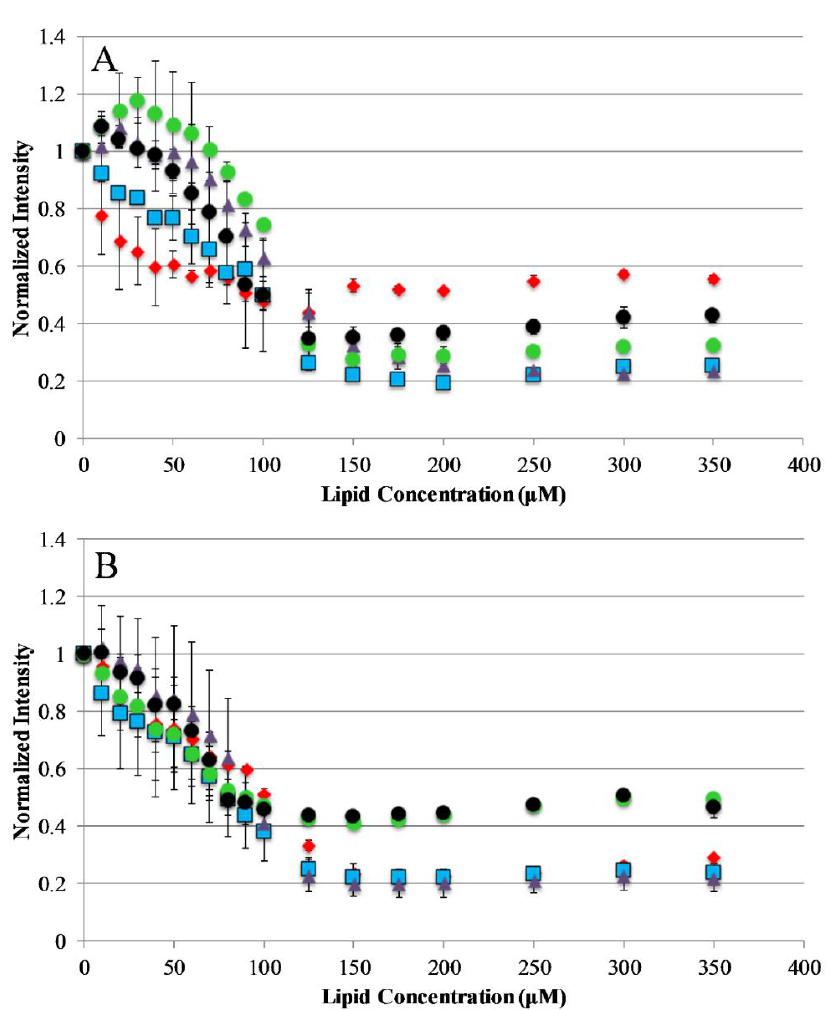
Figure 2. Peptide binding to lipid vesicles: Peptide interaction with lipid vesicles was monitored using Trp emission spectra. The normalized Trp emission intensity is shown for each AP peptide titrated with either 75/25% PCPG ( A ) or 100% PC ( B ) lipid vesicles. For both graphs, AP3 is shown as red diamonds, AP3K as blue squares, APX as purple triangles, APX-17 as black circles, and APX-12 as green circles. Peptide concentration was 2 μM in all cases. Data shown are corrected for background fluorescence and represent averages of at least three replicate samples. Error bars represent the standard deviation of these data.